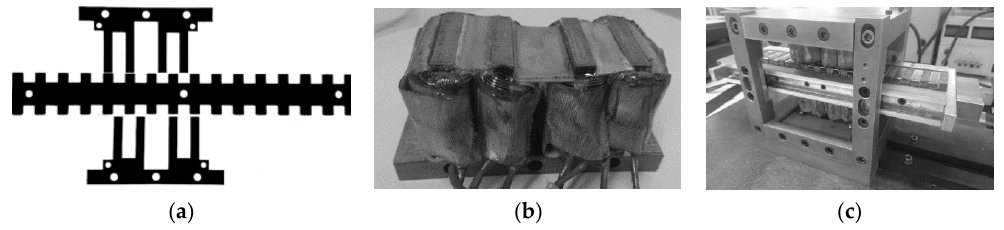
Figure 12. ( a ) Lamination of U-cores and mover. ( b ) Detail of one U-core with the stator coils. ( c ) View of the complete actuator.